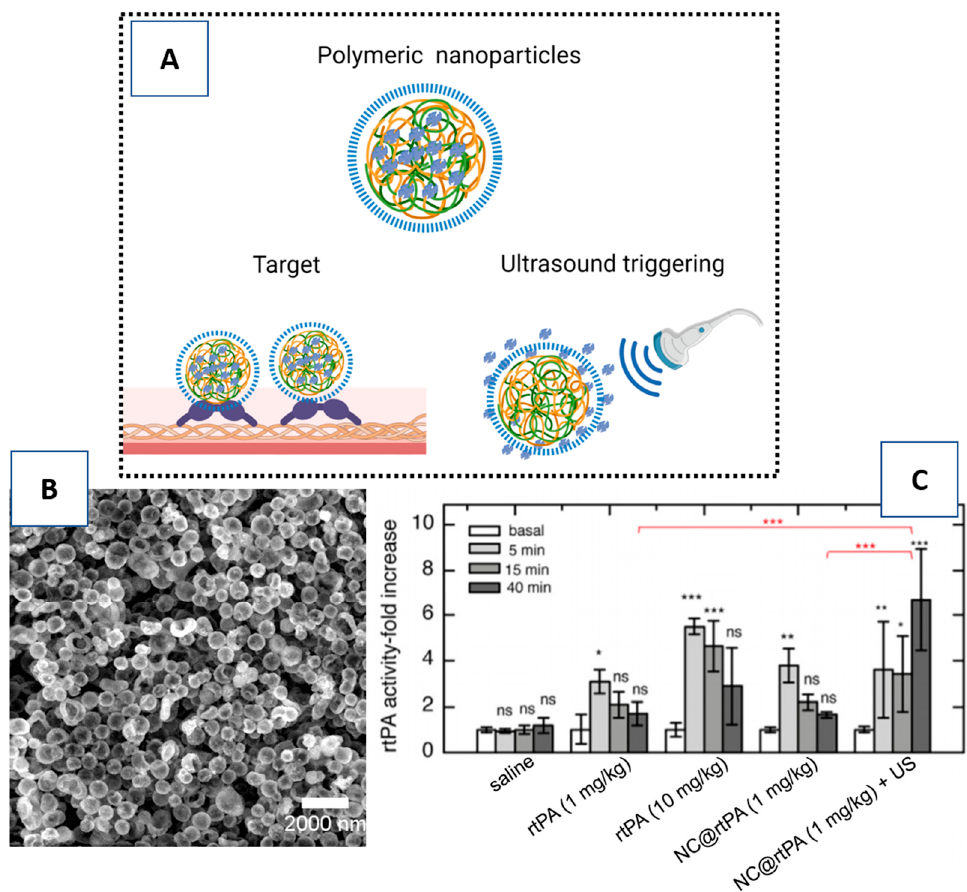
Figure 8. Echogenic polymeric nanocapsules covered by gelatin and encapsulating rtPA. ( A ) A schematic representation of echogenic polymeric nanocapsules covered by gelatin and encapsulating rtPA. The gelatin binds to the von Willebrand factor of the thrombus, and ultrasound triggers the release of rtPA. ( B ) Scanning electron microscopy (SEM) image of the nanocapsules. ( C ) In vivo release of rtPA from nanocapsules by ultrasound (US). Ns (no significance); * p < 0.05; ** p < 0.01; *** p < 0.001. Figure ( A ) created with BioRender.com. Figure ( B , C ) modified from